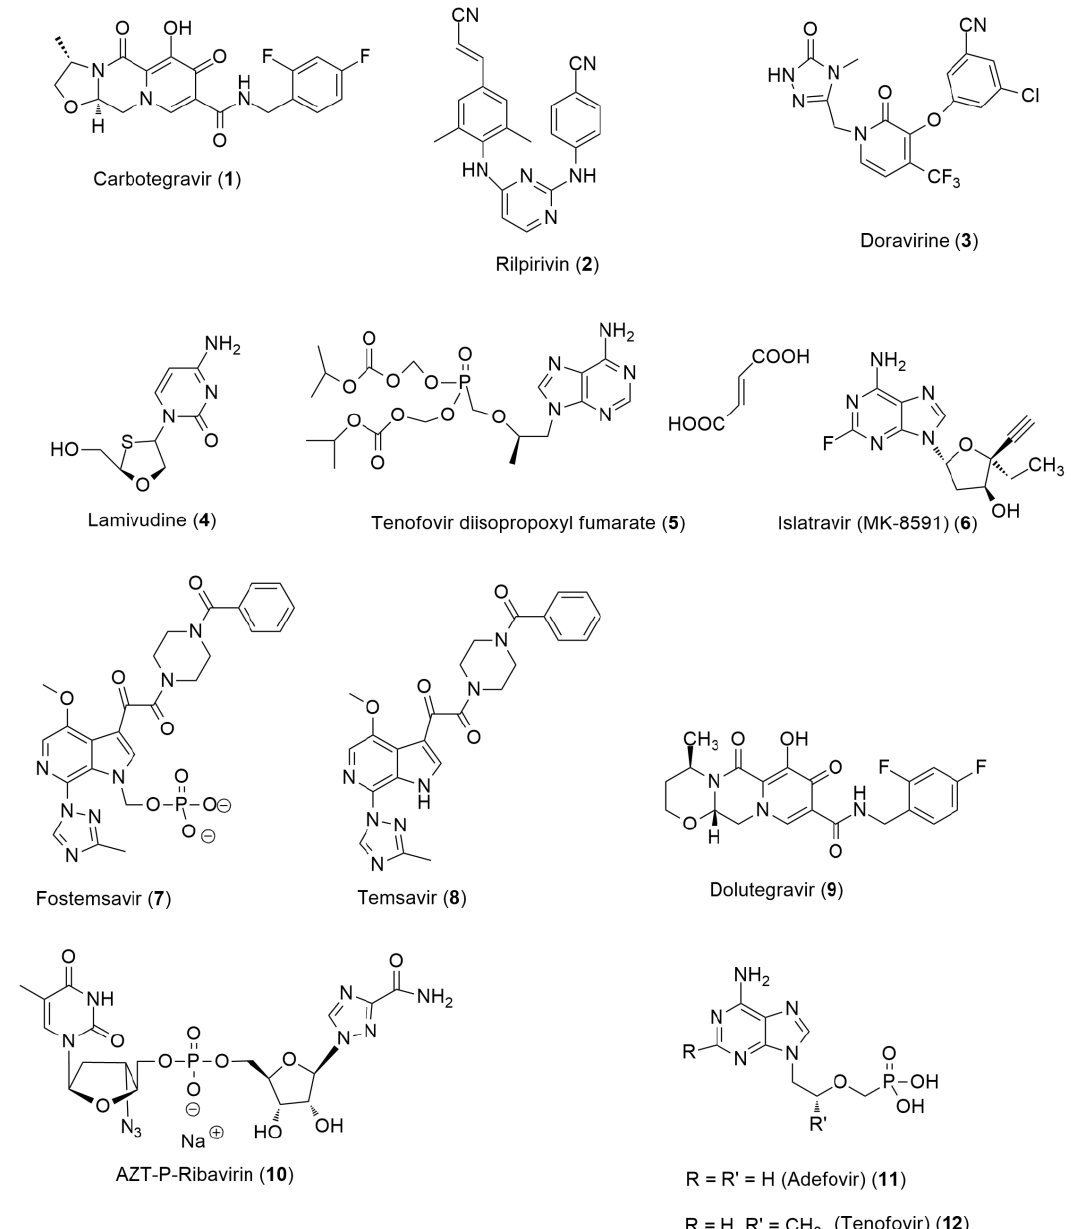
Figure 6. Direct-acting anti-HIV agents.